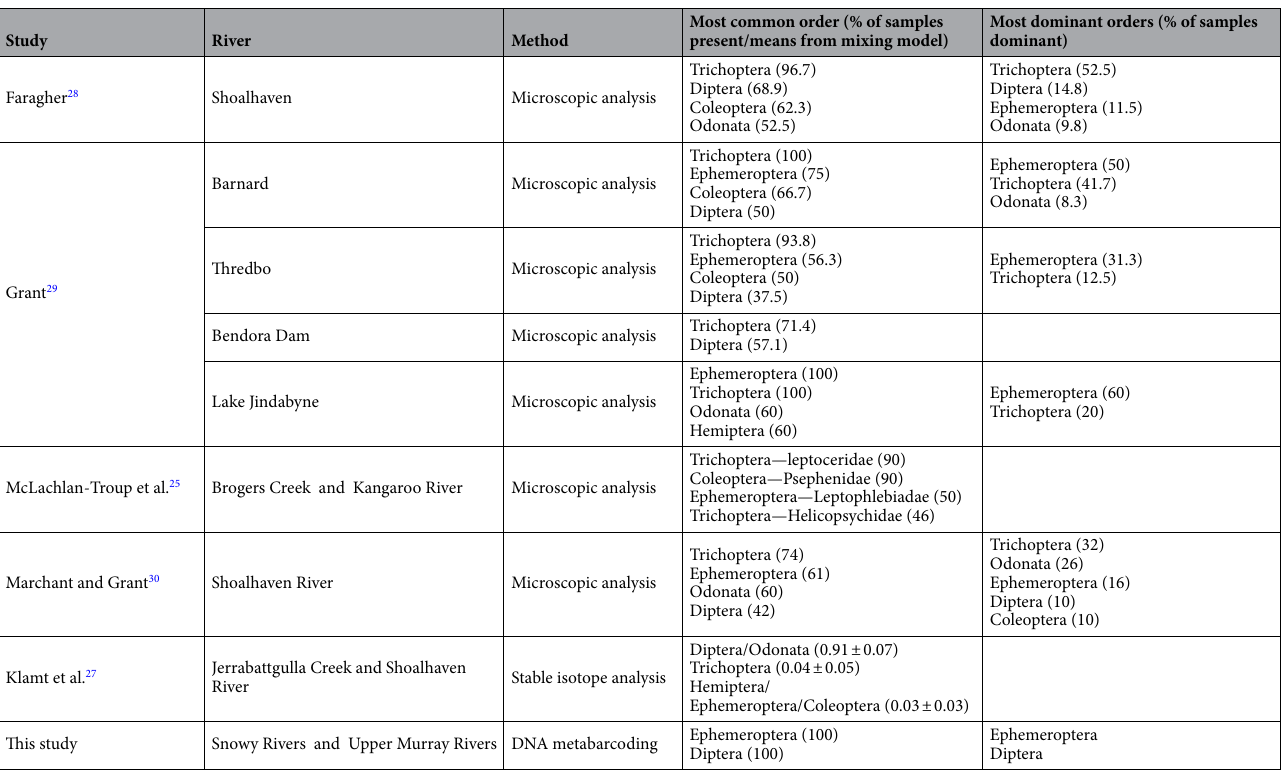
Table 1. The top four (where available) most common and dominant macroinvertebrate orders in the diet of platypuses from studies using different methodologies from different rivers and